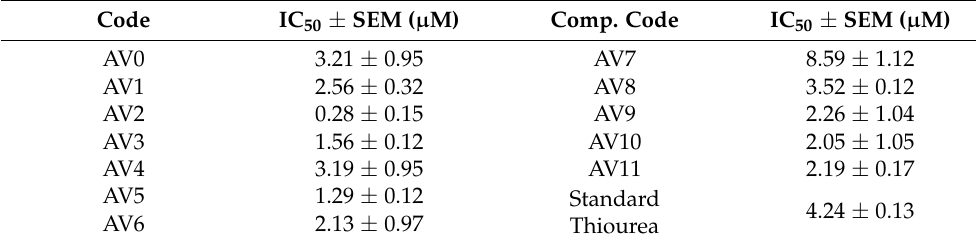
Table 5. Results of urease enzyme inhibition of synthesized derivatives of 2-(N-((2 (cid:48)